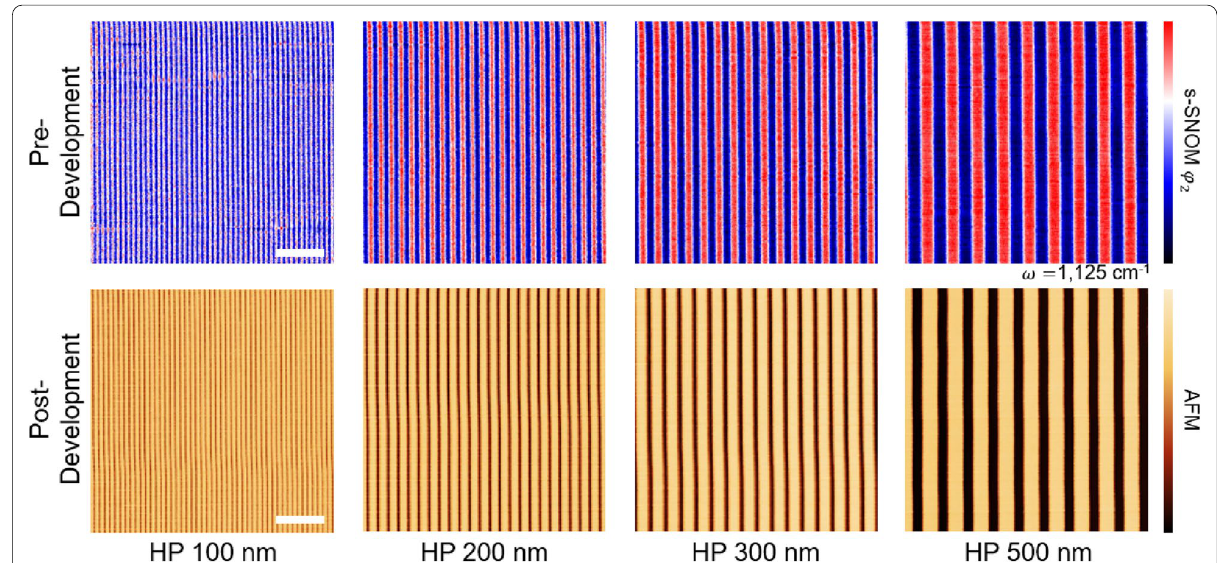
Fig. 4 (Top) s‑SNOM results of the pre‑development chemical pattern visualization of latent images with the 1125 cm − 1 infrared laser. The red color indicates higher infrared absorption. (bottom) Post‑development pattern inspection of atomic force microscope (AFM) for half‑pitch (HP) 100, 200, 300, and 500 nm patterns. The scale bar is 2